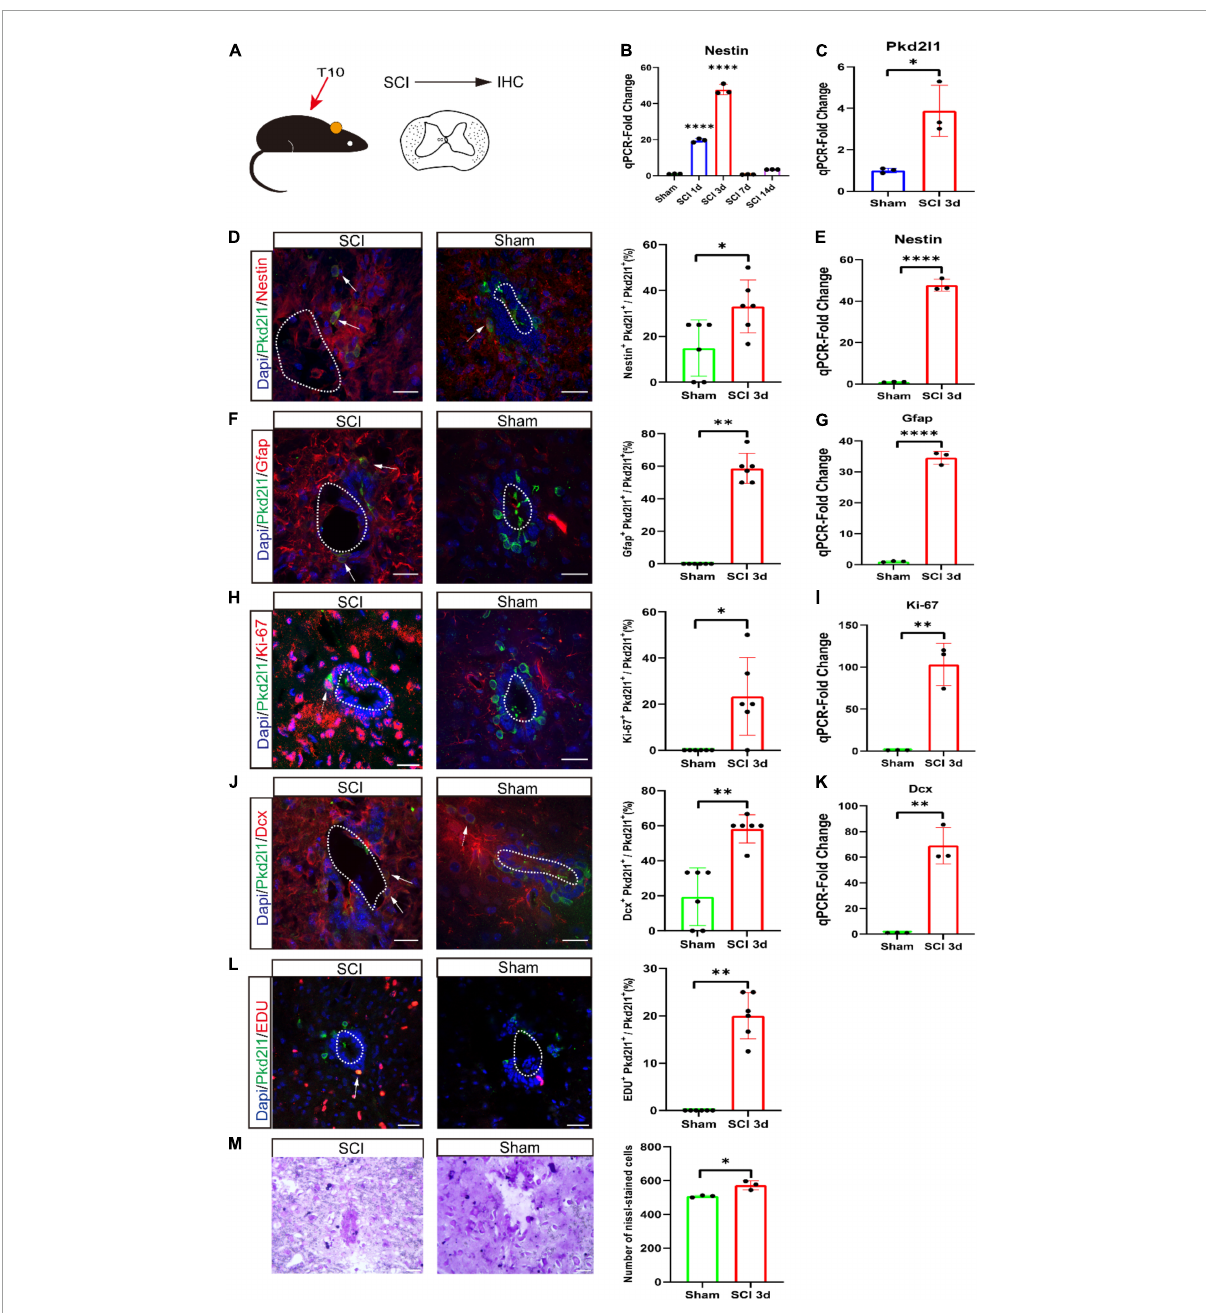
FIGURE5 Cerebrospinal fluid-contacting neurons (CSF-cNs) activating proliferative or neurogenic potential after spinal cord injury (SCI). (A) SCI was performed at the T10 level, and IHC was analyzed. IHC, immunohistochemistry. (B) qRT-PCR analysis of Nestin expression in the spinal cords at different stages after SCI. (C) qRT-PCR demonstrated a significant increase in Pkd2l1 expression at 3 days after SCI compared to Sham. (D,E) Upregulation of Nestin (red) in Pkd2l1 positive cells (green) at 3 days post-SCI. Quantification of Nestin co-expression in PKD2L1 positive cells at 3 days post-SCI compared to sham. qRT-PCR demonstrated a significant rise in Nestin expression at 3 days after SCI compared to Sham. (F,G) The increase in expression of Pkd2l1 positive cells (green) at 3 days post-SCI. Quantification of Gfap co-expression in Pkd2l1 positive cells